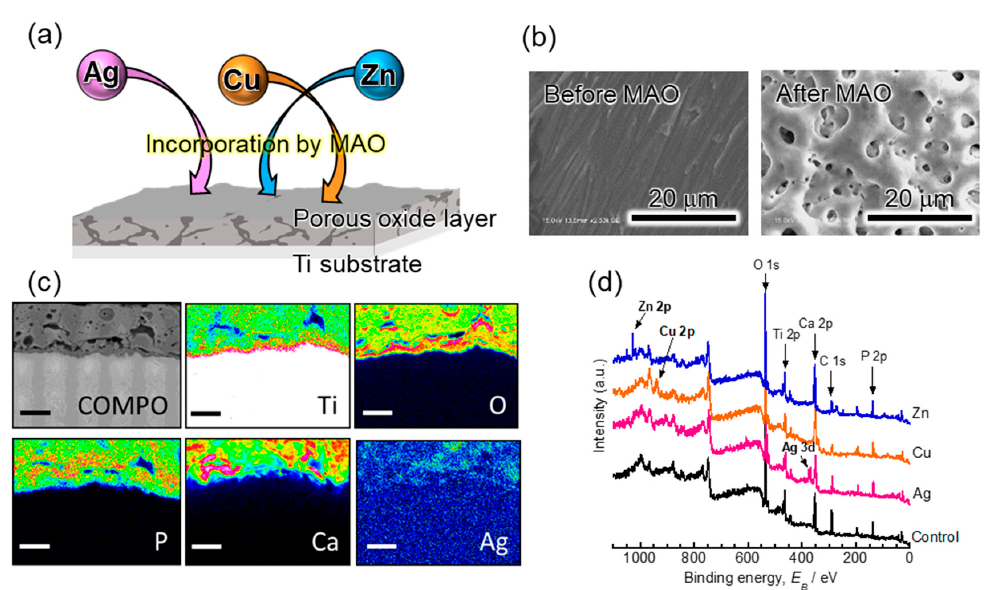
Figure 2. ( a ) Schematic diagram of the formation of a porous oxide layer on the Ti substrate and the incorporation of antibacterial elements by micro-arc oxidation (MAO). ( b ) Scanning electron microscopy (SEM) images of the Ti surface before and after MAO; ( c ) cross-sectional views of Ag-incorporated porous oxide layer and element mapping results by electron probe micro analyzer (EPMA). Scale bar represents 10 µm; ( d ) X-ray photoelectron spectroscopy (XPS) survey scan spectra obtained from the specimen, with and without antibacterial elements. The spectra obtained from the control (specimen without antibacterial elements), Ag-, Cu-, and Zn-incorporated specimens are shown from the bottom to the top. Specimens were MAO-treated at 400 V using the electrolytes containing 150 mM of calcium acetate and 100 mM of calcium glycerophosphate with or without 2.5 mM of silver nitrate, 2.5 mM of copper chloride, or 2.5 mM of zinc chloride.